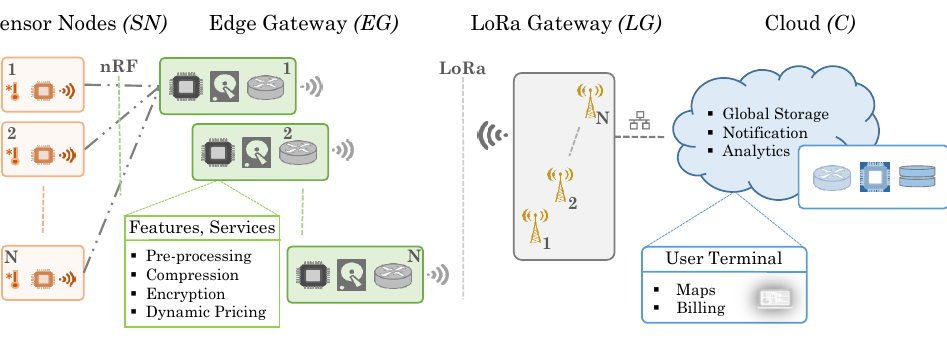
Figure 3. Proposed multi-layer system